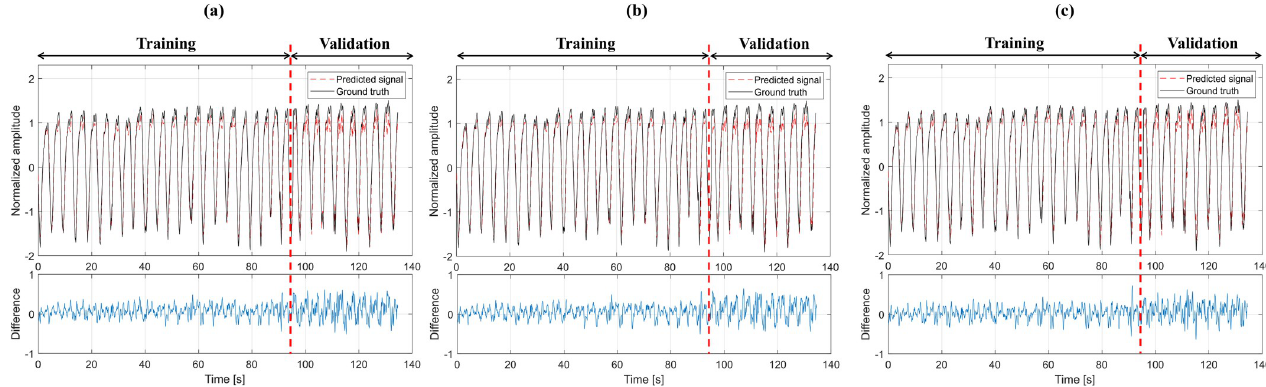
Fig 3. Plots of actual (solid line) and predicted respiratory signals (dotted line). (a) LSTM, (b) Bi-LSTM, and (c) Transformer. The difference is an absolute value (true signal amplitude–predicted signal amplitude).